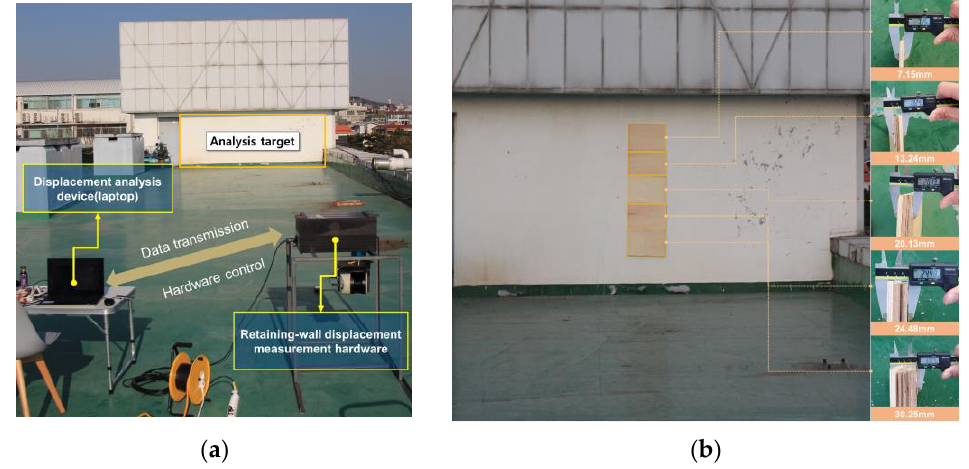
Figure 9. Testbed for evaluating the performance of the retaining wall displacement measurement system. ( a ) Scene of the performance test; ( b ) simulation of retaining wall deformation.